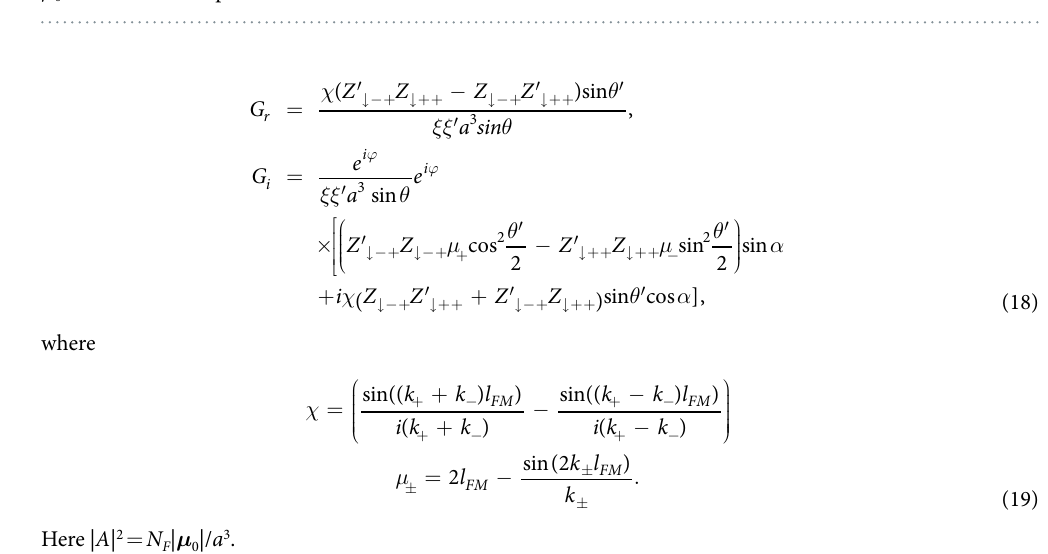
Figure 5. The real parts and the imaginary parts of G r , i are plotted as a function of the FMM thickness l FM / a and s-d coupling − gS / E . The units of the spin mixing conductance is e 2 / ħa 2 . We set θ = 0.3 π , γ / E = 0.1, and = 0.01 for this μ 0 / E